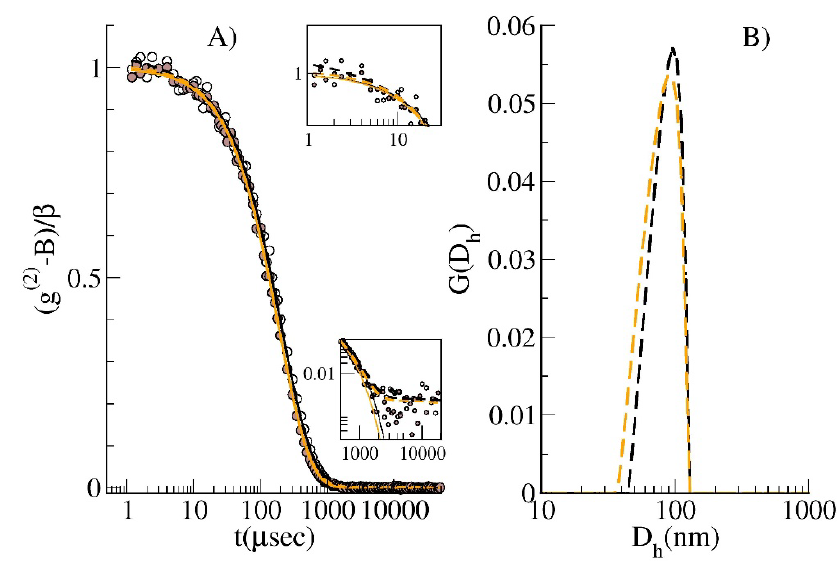
Figure 1. DLS analysis at θ = 90° for POPC_LIPO_50, as a representative sample. ( A ) intensity autocorrelation function, ( g (2) - B )/ β for extrusion I (empty circle) and II (brown circle); lines represent the fitting curves according to the cumulants (continuous lines) and contin analysis (dashed lines). Fit difference is evidenced in the insets in a log–log scale. Upper inset: zoom of low t range. Lower inset: zoom of high t-range. ( B ) Intensity weighted size distribution arising from contin analysis: extrusion I (black dashed) and II (orange dashed).